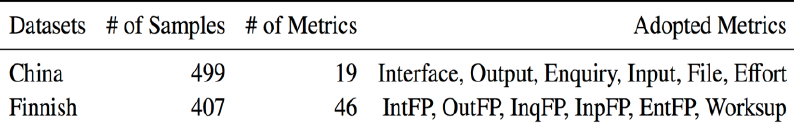
Table 1. Description of analyzed